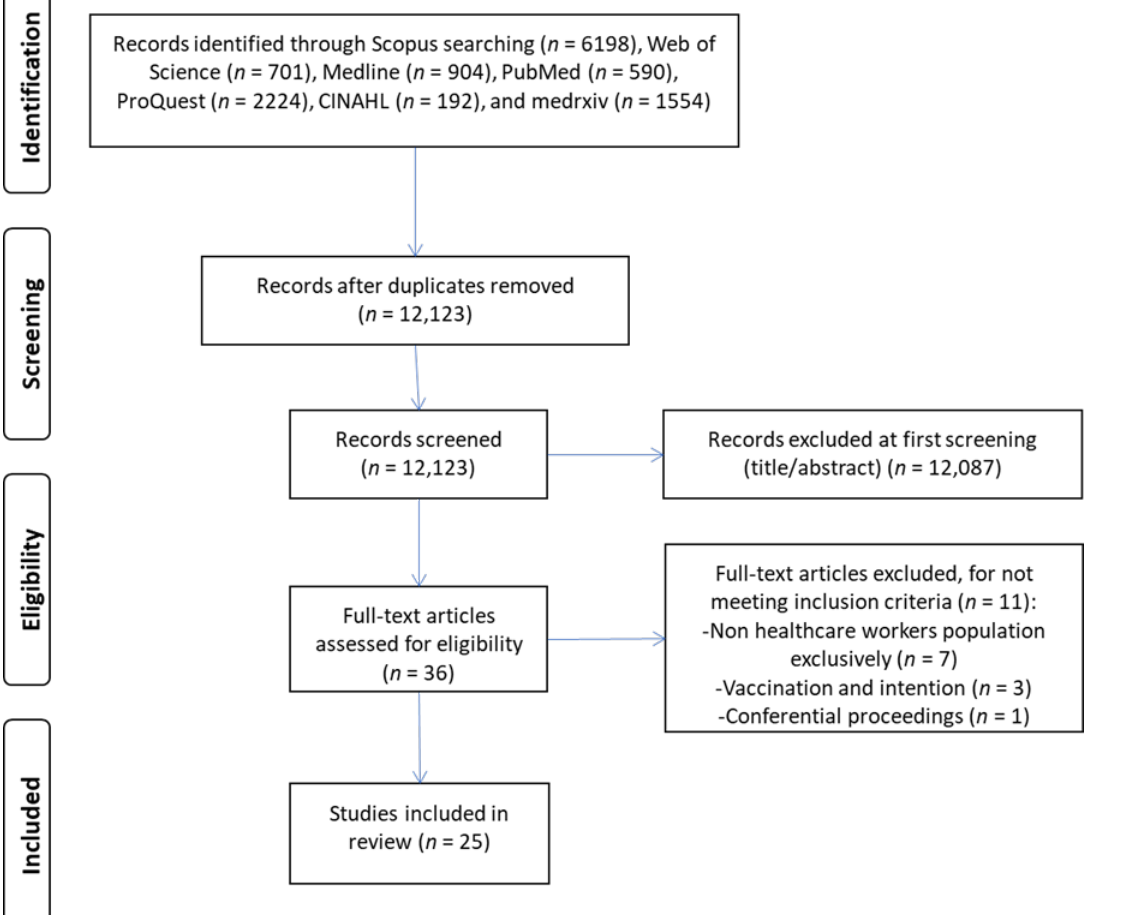
Figure 1. Flowchart of the literature search according to the PRISMA guidelines.